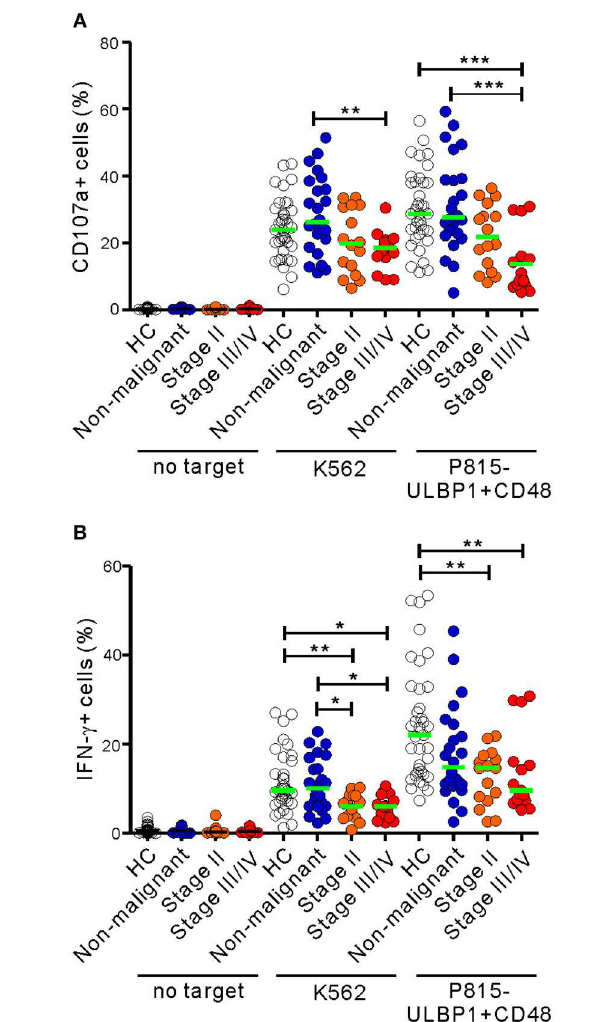
FIGURE 2 | NK cell dysfunction correlates with the clinical severity of PC. The malignant group was divided into subgroups on the basis of cancer progression (stage II vs. stage III/IV). PBMCs from the healthy control (HC) group ( n = 37), the non-malignant group ( n = 24), the stage II subgroup ( n = 16), and the stage III/IV subgroup ( n = 15) were incubated with or without the indicated target cells, as described in Figure 1 . The percentages of CD107a + (A) and IFN- γ + (B) NK cells are shown. Horizontal bars (green) denote the medians. * P < 0.05, ** P < 0.01, and *** P < 0.001; Kruskal-Wallis